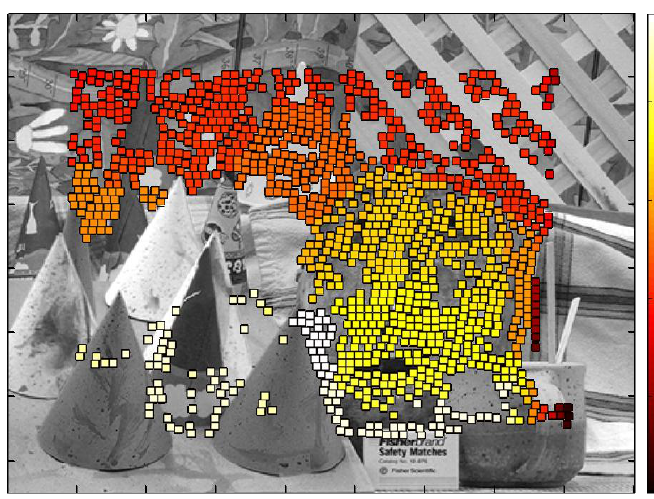
Figure 16. Dense disparity